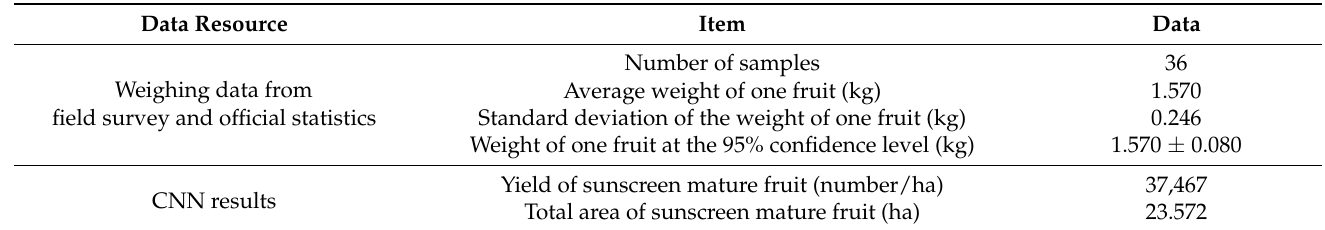
Table 7. The data used for production